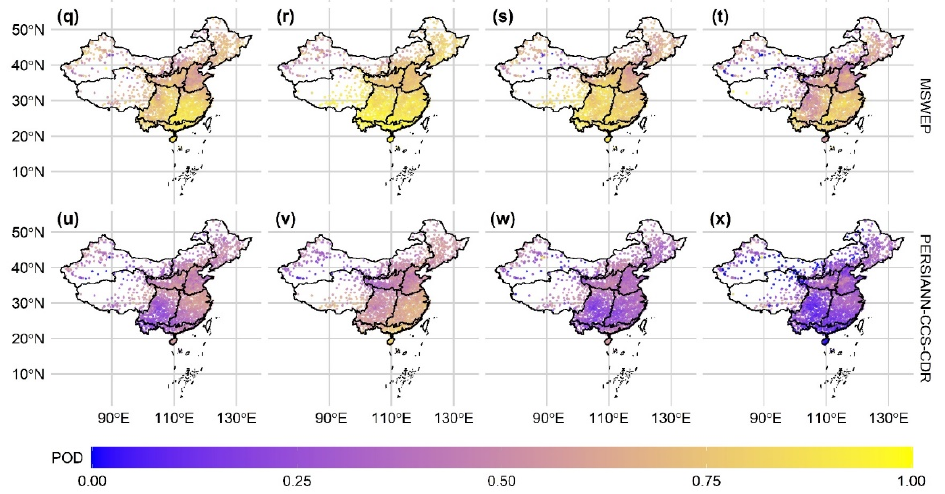
Figure 11. Distribution of POD values of six products for different seasons between 2015 and 2019. From top to bottom: ( a – d ) CHIRPS, ( e – h ) ERA5-Land, ( i – l ) GSMaP, ( m – p ) IMERG, ( q – t ) MSWEP and ( u – x ) PERSIANN-CCS-CDR.